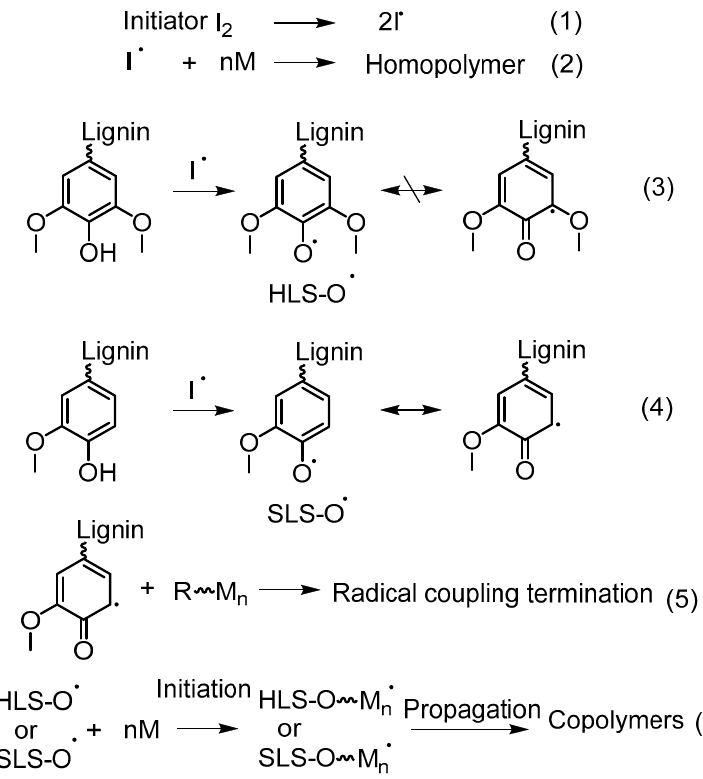
Figure 19. Proposed free radical grafting mechanism of lignin with vinyl monomers. Reproduced with permission [62].